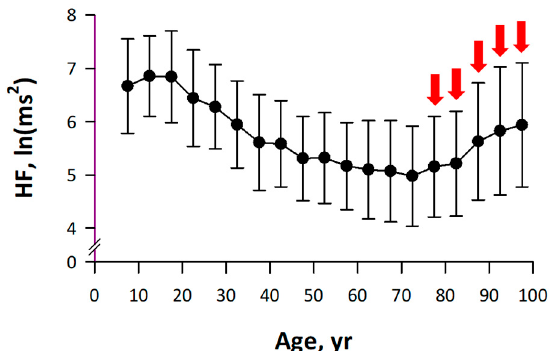
Figure 3. Age-dependent changes in HRV frequency components. Made from data from a previous study [4].